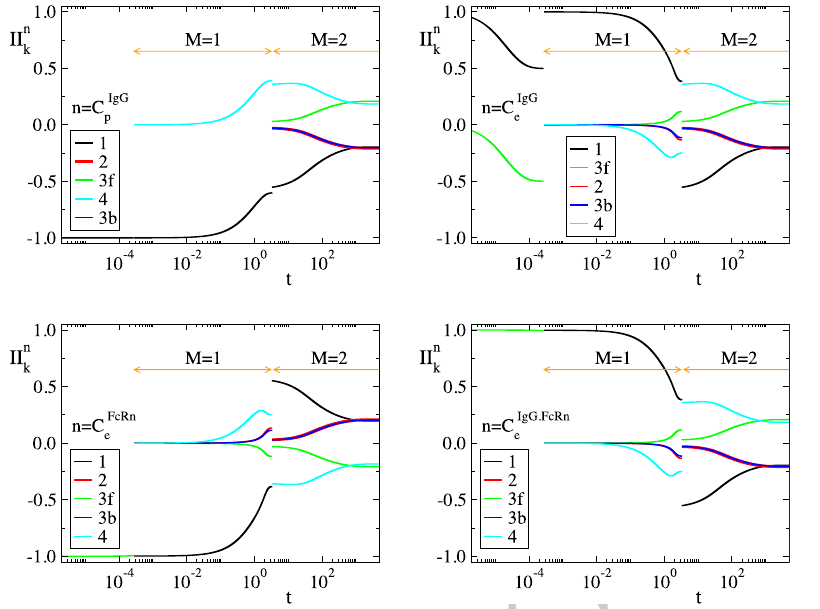
. FcRn IgG IgG FcRn C IgG e , C e ) in p , C e ,